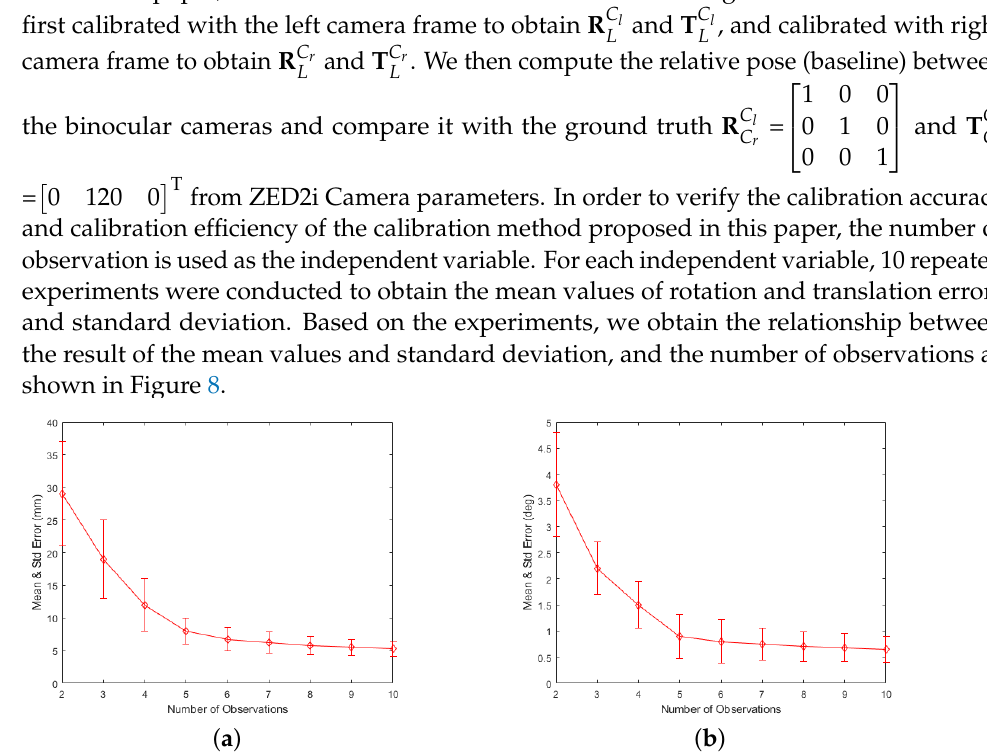
Figure 8. Rotation and translation errors versus number of observations. ( a ) Mean and standard deviation of translational errors. ( b ) Mean and standard deviation of rotation